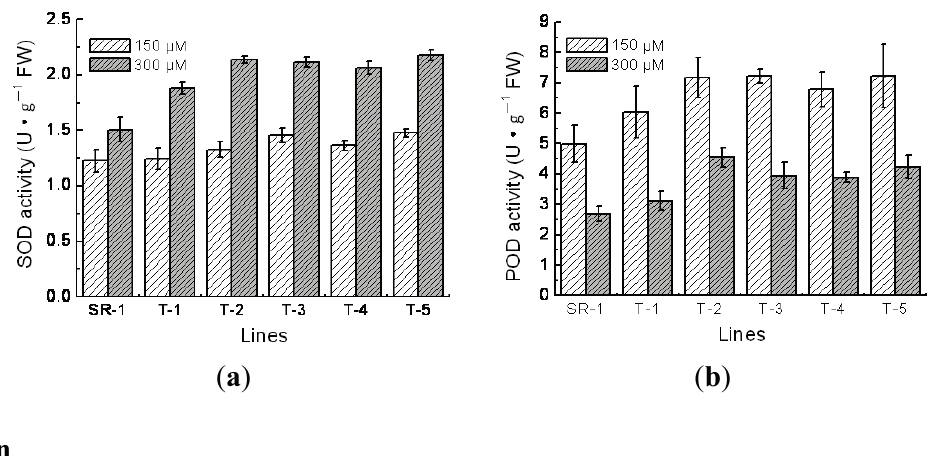
Figure 6. Comparison of SOD ( a ) and POD ( b ) activity among transgenic and non-transgenic tobacco lines. SR-1, non-transgenic tobacco; T-1 to T-5, transgenic tobacco. Mean values and standard deviations were calculated based on the six